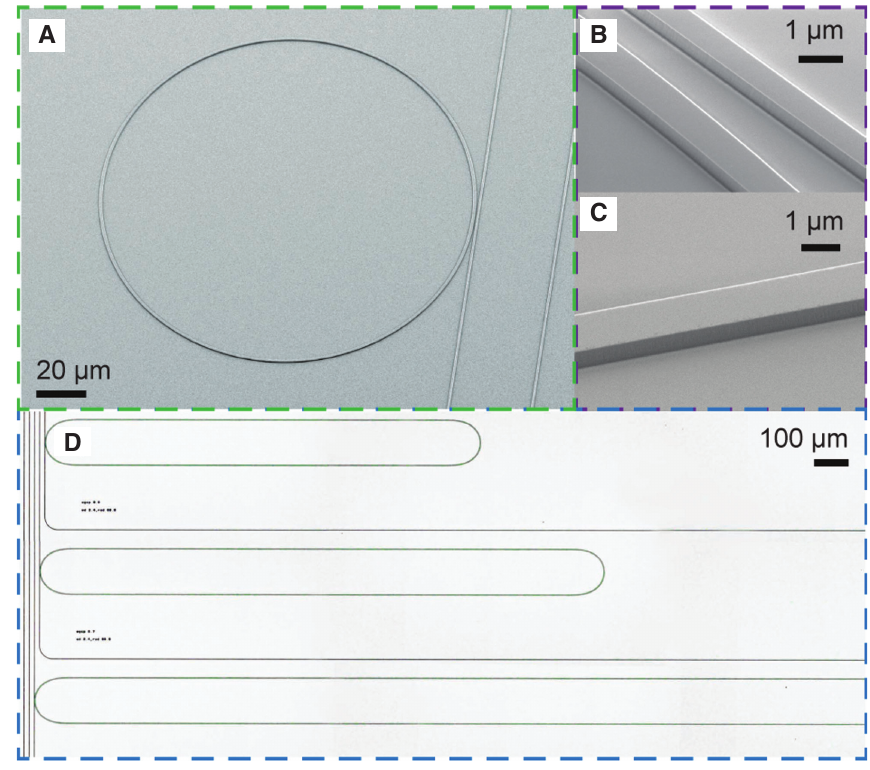
Figure 11: Several typical LNOI microring resonators. (A) Scanning electron microscope of a typical LNOI microring. (B, C) Scanning electron microscope images of waveguides constituting microrings. (D) Optical microscope images of racetrack resonators with different lengths. Reprinted with permission from Zhang et al. [69]. © The Optical Society.